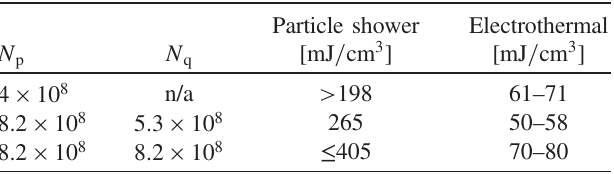
TABLE V. Quench-level comparison; FLUKA calculations and electrothermal estimates of the MQED in the MQ coil for the intermediate-duration orbit-bump quench test. Lower values in the electrothermal estimate correspond to a more pessimistic cooling model; both cooling models neglect a potential increase of cooling power by an enhanced nucleate-boiling